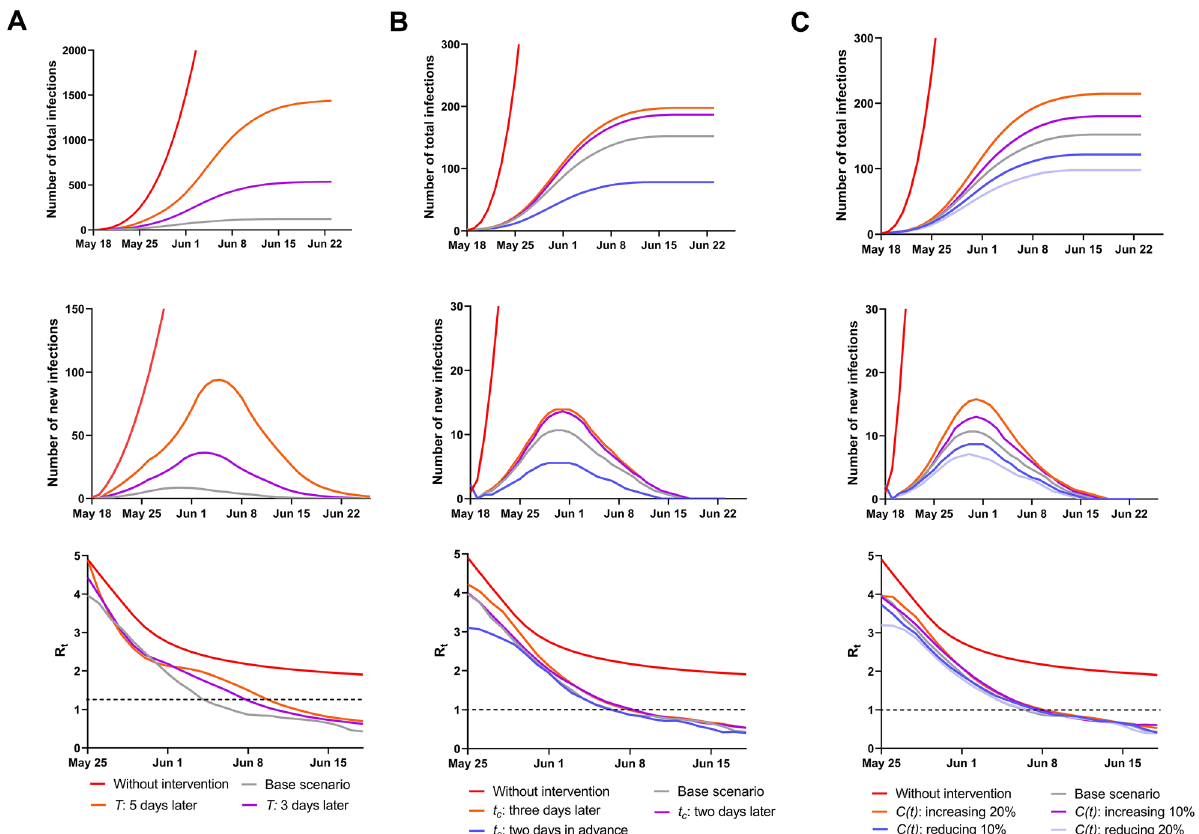
Figure 5. Estimation of effectiveness of Guangzhou interventions under three scenarios. ( A ) timely implementation of control measures ( B ) timeliness of quarantine ( C ) percent change in close contacts owing to social distancing. Base scenario: model with Guangzhou interventions; T : Time of response to t whole control measure (phase I – IV) in Guangzhou; t c : time from onset of infectiousness to quarantine/isolation; C(t) : Average contact